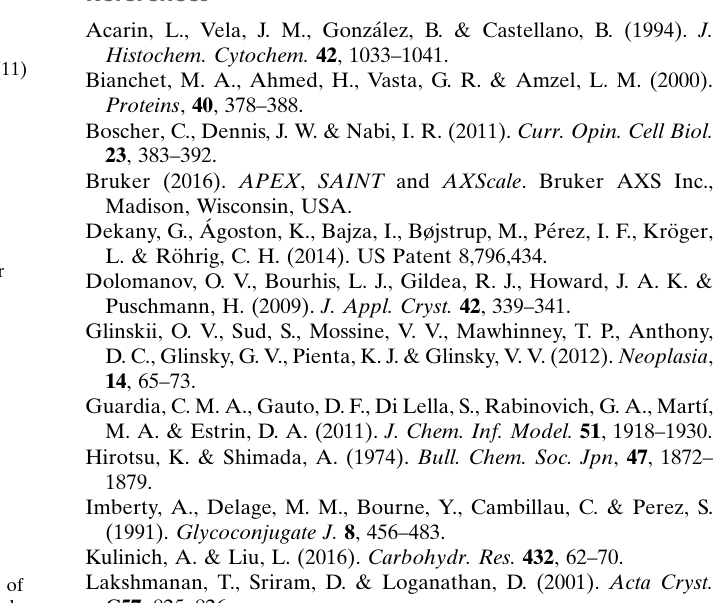
Crystal data Chemical